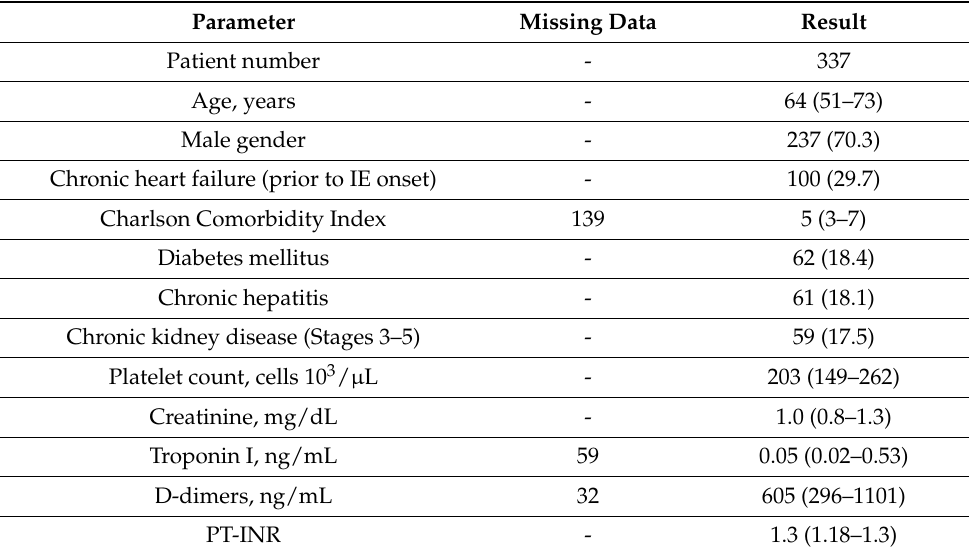
Table 1. Baseline characteristics of the study